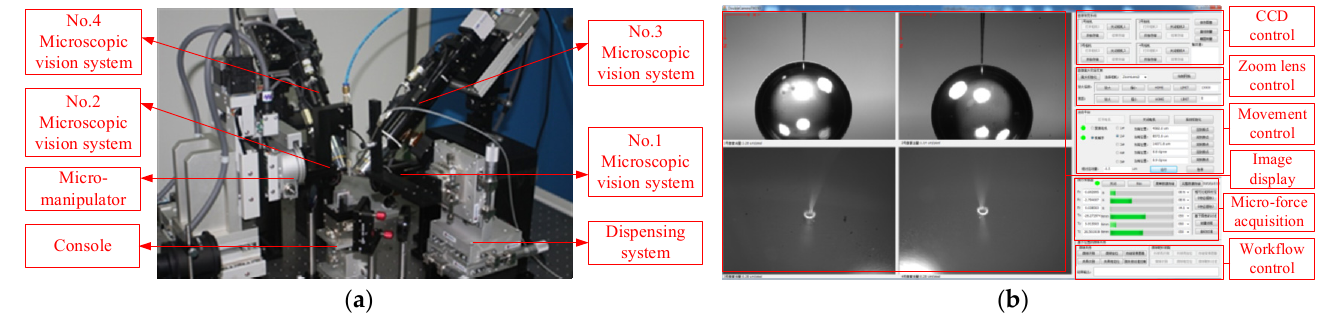
Figure 1. Diagram of assembly process: ( a ) attitude alignment; ( b ) position alignment; ( c ) insertion depth control; ( d ) dispensing process.